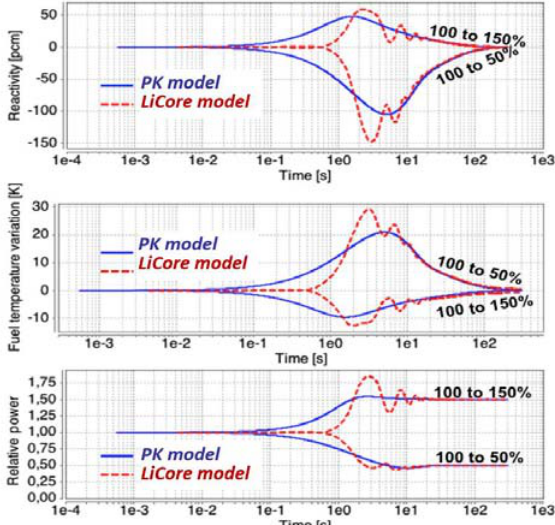
Figure 3. Comparison of LiCore and a point-kinetic model (PK).